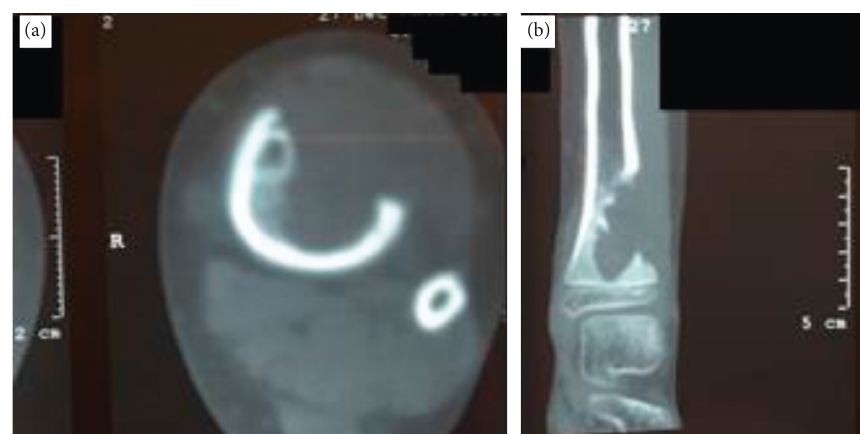
Figure 4: (a) Axial CTshowing destruction of the anterior tibial cortex with extension into soft tissue. (b) Coronal CTshowing ill-defined distal tibial lesion with cortical destruction.